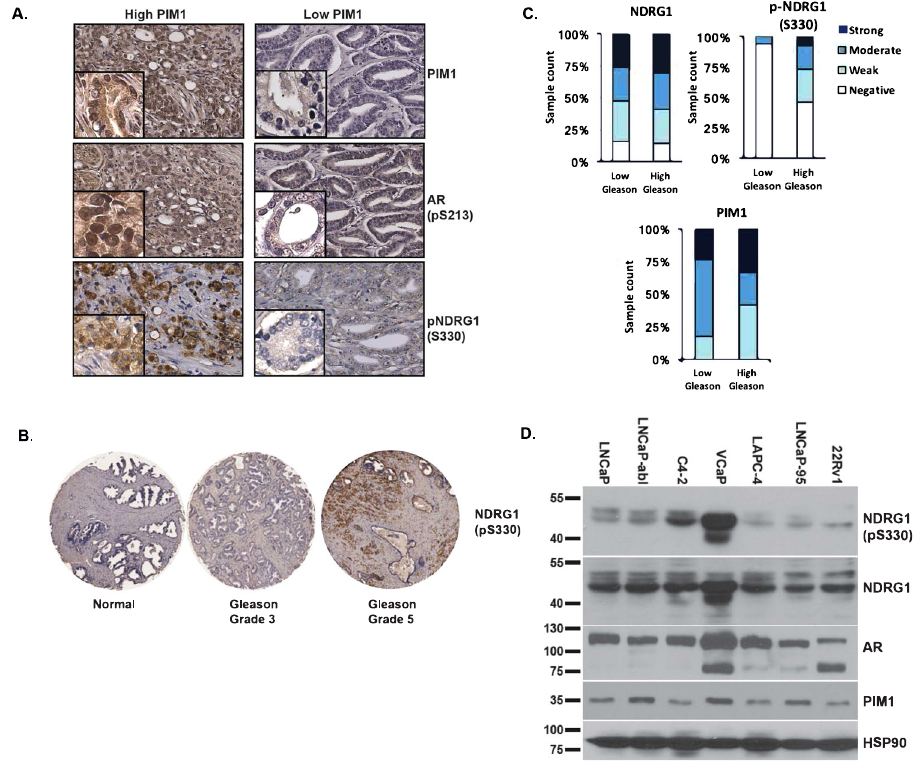
Fig. 4 NDRG1 phosphorylation is positively associated with PIM1 expression and high Gleason grade in primary prostate cancer. A Immunohistochemistry (IHC) of PIM1, AR pS213, and NDRG1 pS330 in primary prostate cancer samples ( n = 67) with low PIM1 and high PIM1 levels. B IHC of NDRG1 pS330 in normal prostate, low Gleason grade, and high Gleason cases. C IHC analysis comparing NDRG1 pS330 and total NDRG1 in low Gleason tumors versus high Gleason tumors ( n = 76). D Western blot analysis of NDRG1 pS330, total NDRG1, AR, PIM1 in different prostate cancer cell lines. HSP90 was used as loading